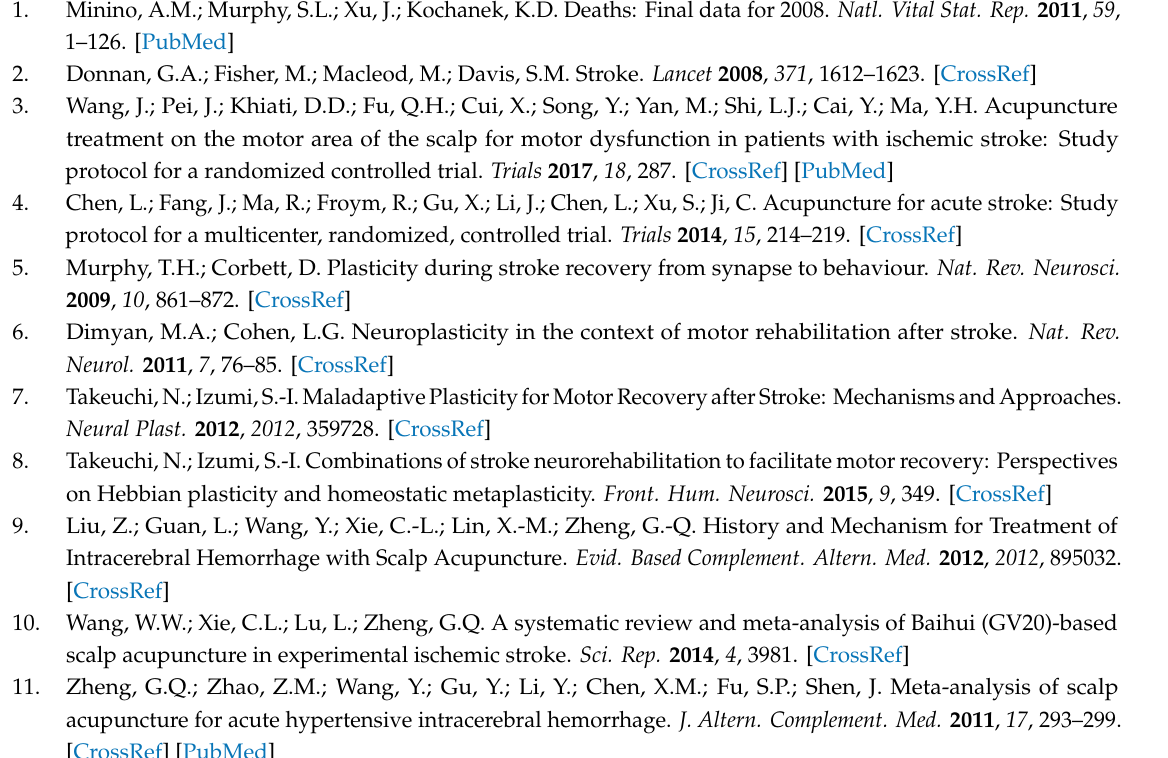
Table S1: CONSORT 2010 checklist of information to include when reporting a randomized trial. Table S2: STRICTA checklist. Table S3: Full version of changes in outcome measures after treatment completion in four